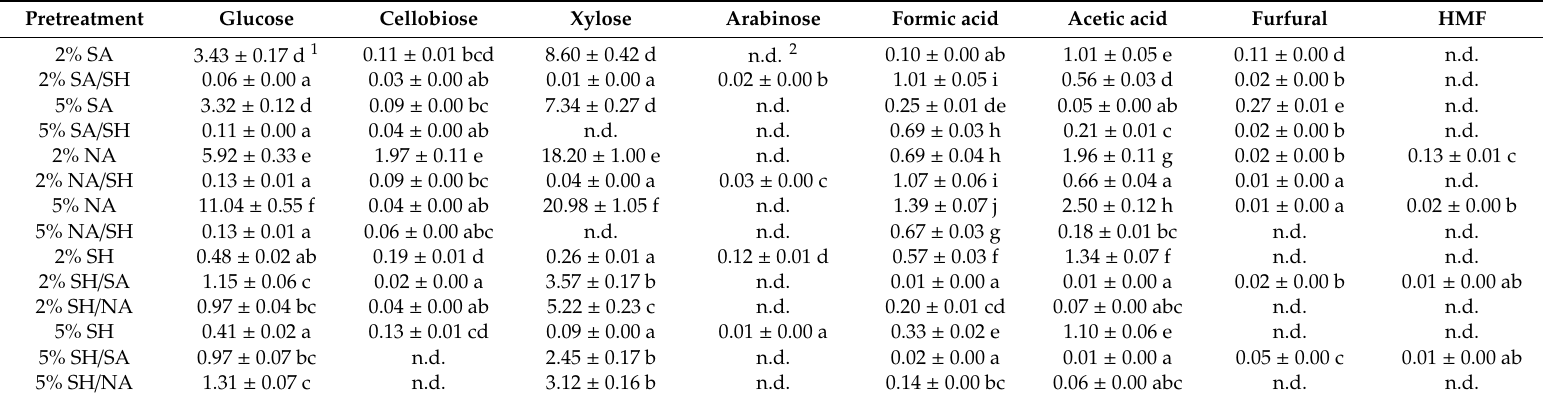
Table 3. Concentration of sugars, organic acids and furan compounds (g / L) in liquids after single and two-stage pretreatment of OS.